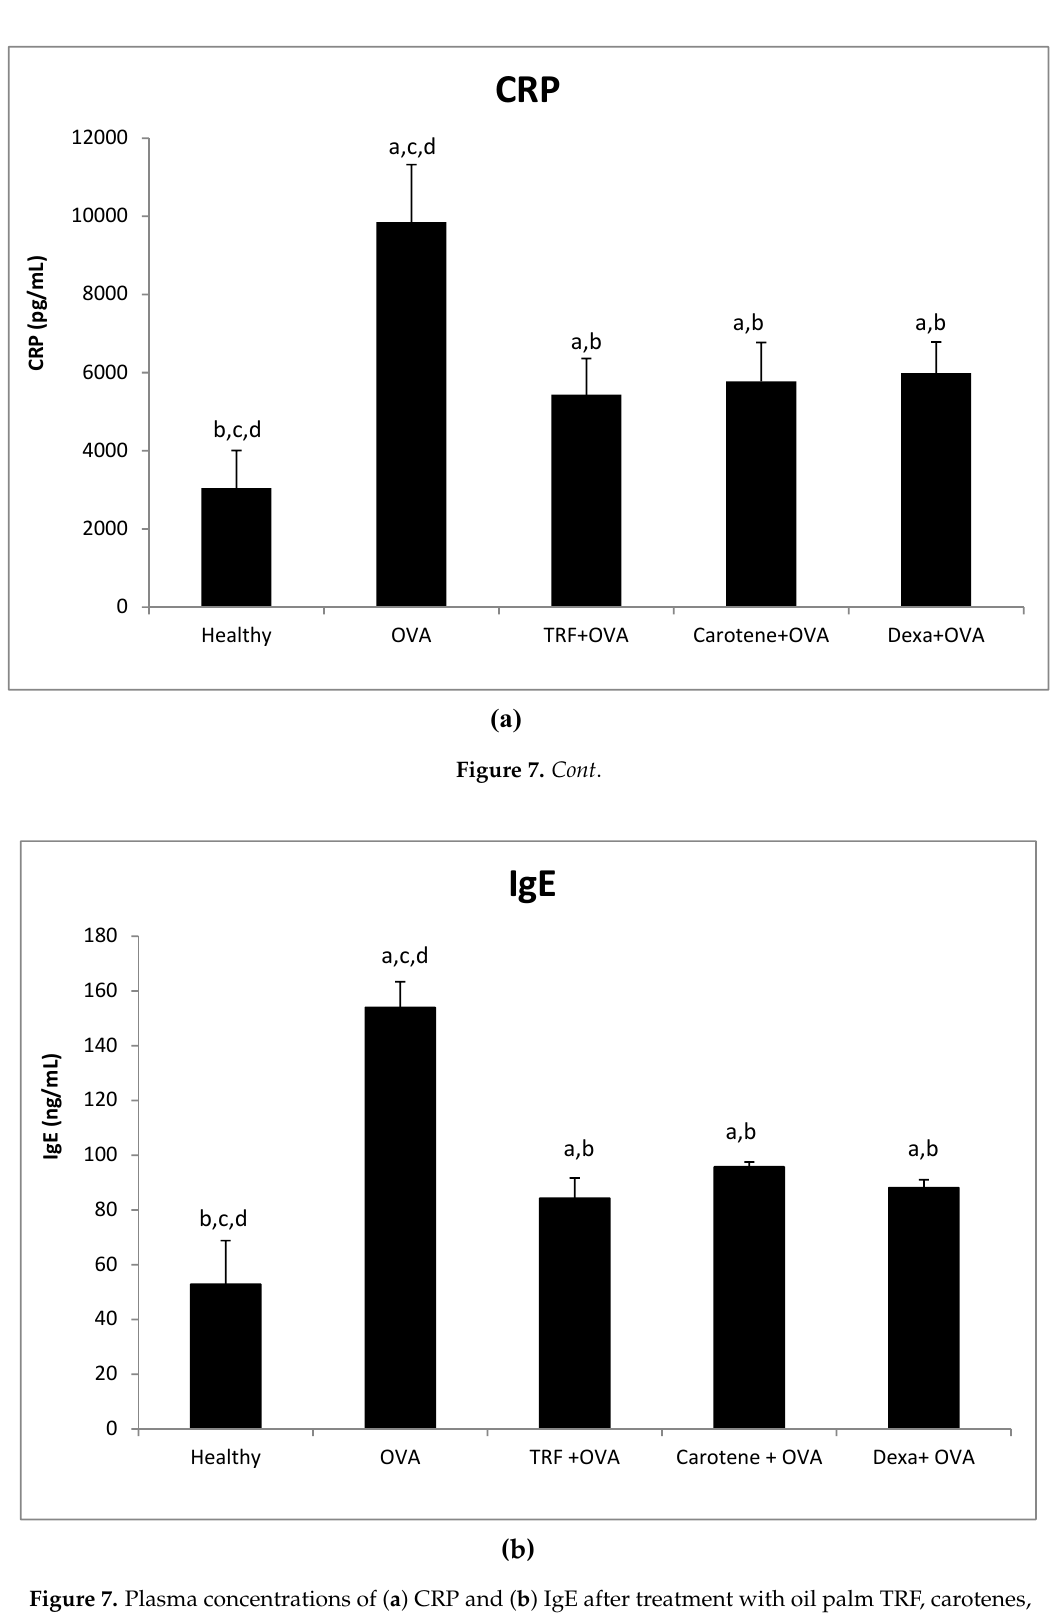
Figure 7. Plasma concentrations of ( a ) CRP and ( b ) IgE after treatment with oil palm TRF, carotenes, and dexamethasone (Dexa). Data are presented as the means ± SD, n = 10 rats per group. a ( P < 0.05) versus the control group. b P < 0.05 versus the OVA challenged group c P < 0.05 versus OVA + TRF, d P < 0.05 versus OVA + Dexa.